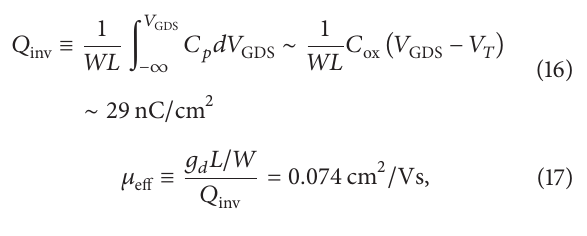
where 𝐶 is oxide capacitance measured as the step of the ox 𝐶 - 𝑉 plot at 𝑉 = 0 V (inversion zone) according to Figure 6, GDS while the threshold voltage 𝑉 𝑇 is taken as − 0.25 V and is matching the corresponding value in Table 4 at 77 K. The channel conductance 𝑔 𝑑 is 21 nS as measured from the slope - 𝑉 plot at 𝑉 = 0 V in Figure of the 𝐼 DS DS GS